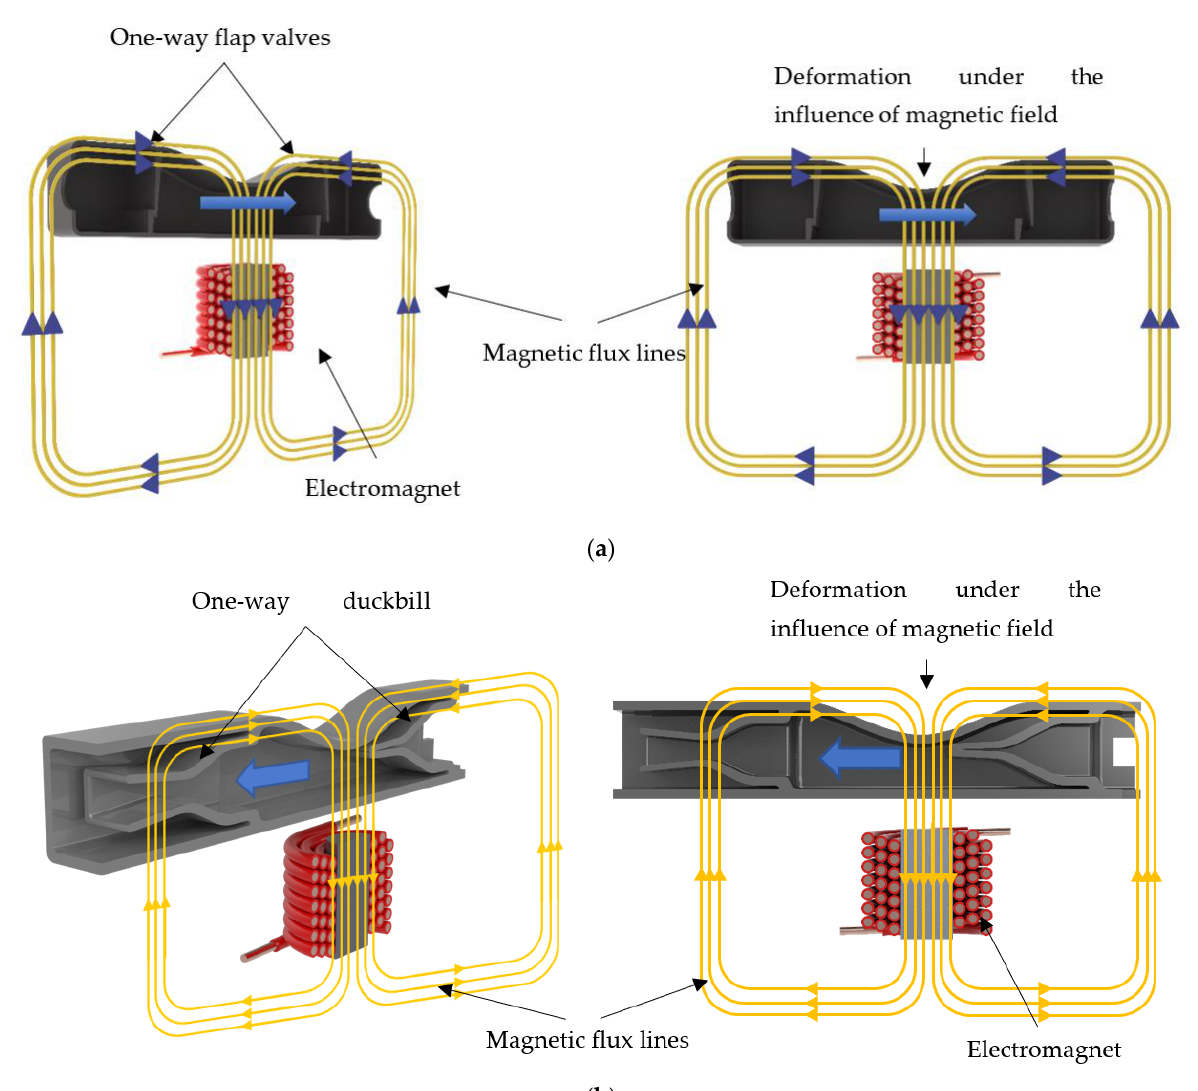
Figure 1. The proposed micropump designs with their main components: ( a ) flap valve model; and ( b ) duckbill valve model.